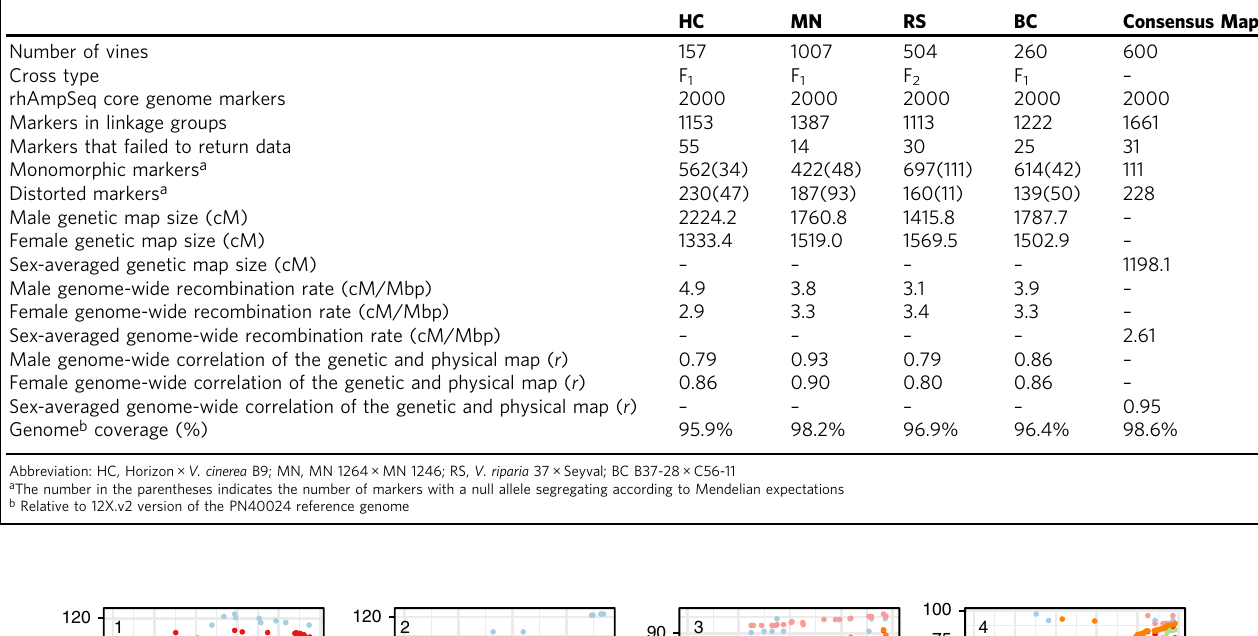
Table 1 Summary statistics of the genetic maps of each family and the consensus genetic